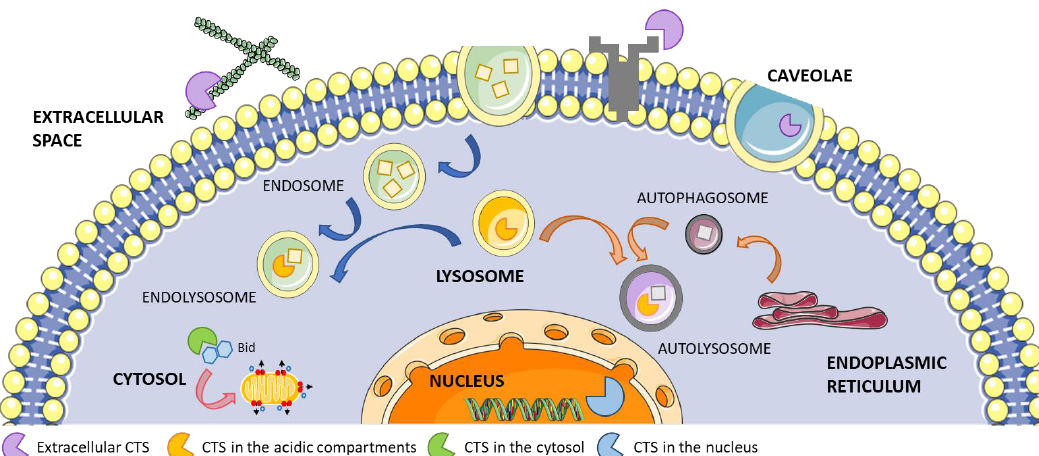
Figure 1. Cellular localization of cathepsins (CTSs). Here, we provide some examples of CTS functions in the different locations. CTSs in the extracellular space can cleave extracellular matrix proteins, cell receptors, or cytokines [2]. CTSs can also be found in caveolae triggering cell-surface proteolytic events associated with cell migration [3], or in the endolysosomal [4] and autolysosomal compartments where they process the compartment’s cargo [5]. CTSs in the nuclei play an important role in cell cycle